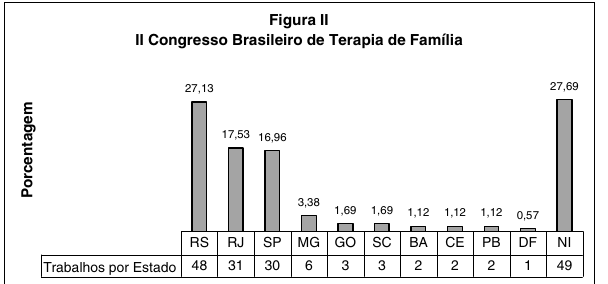
Figura II II Congresso Brasileiro de Terapia de Família